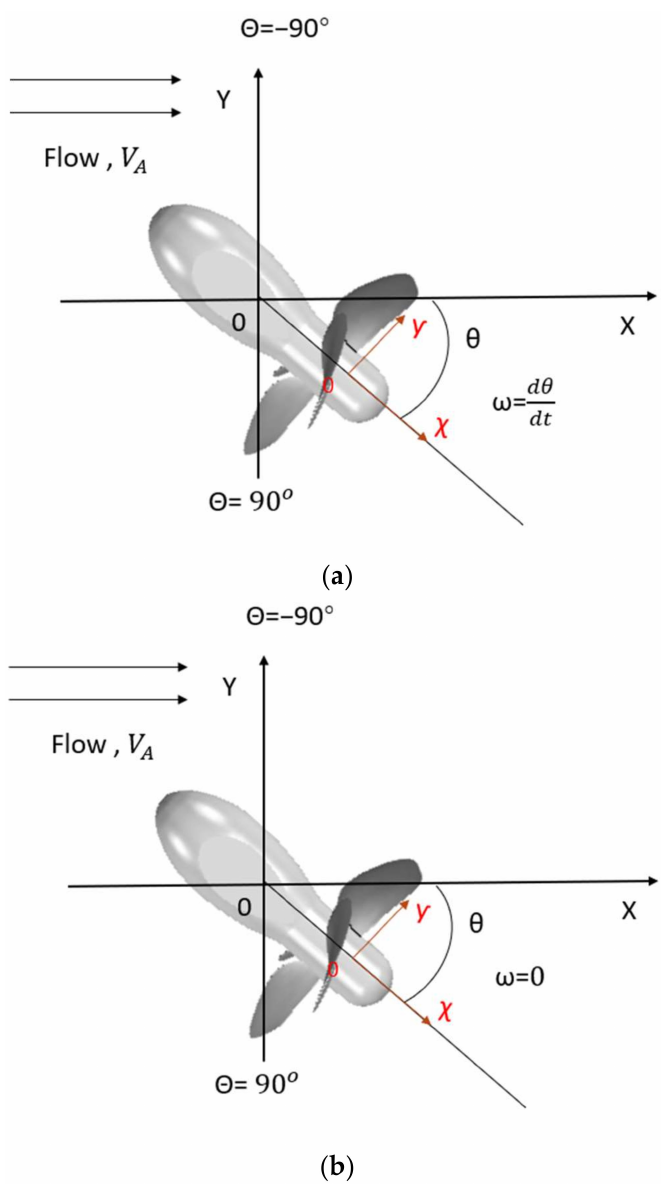
Figure 5. Uptown view of the pod unit in oblique flow: ( a ) Maneuvering condition ( b ) Steady condition. Figure 6 shows a schematic of the load on the pod unit where T x , T y , and T z , are the thrust of the propeller in the axial, lateral, and vertical directions of the propeller. Q px , Q py , and Q pz are the moment of the propeller in the axial, lateral, and vertical torques of the propeller, respectively. F x , F y , and F z are rotational angular velocity, respectively. The load on the propeller is fixed in the o-x-y rotating coordinate system, and the load on the pod unit is fixed in the O-X-Y stationary coordinate